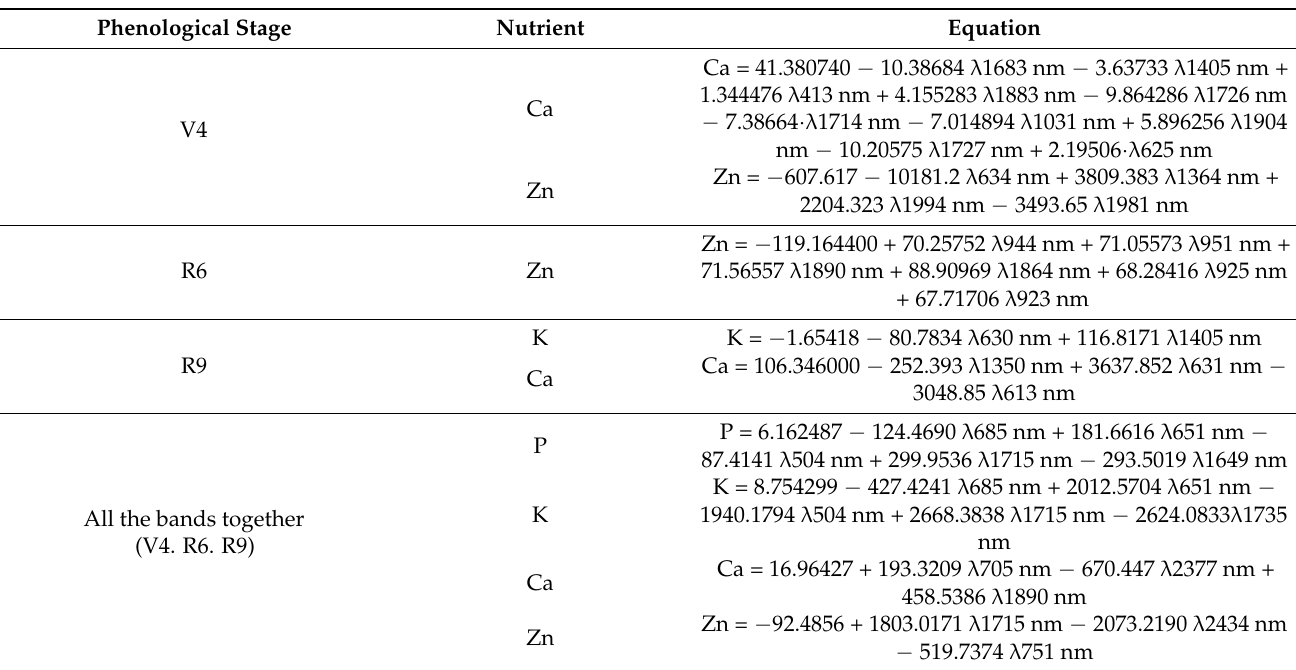
Table 5. Equations used in calibrating the PLSR